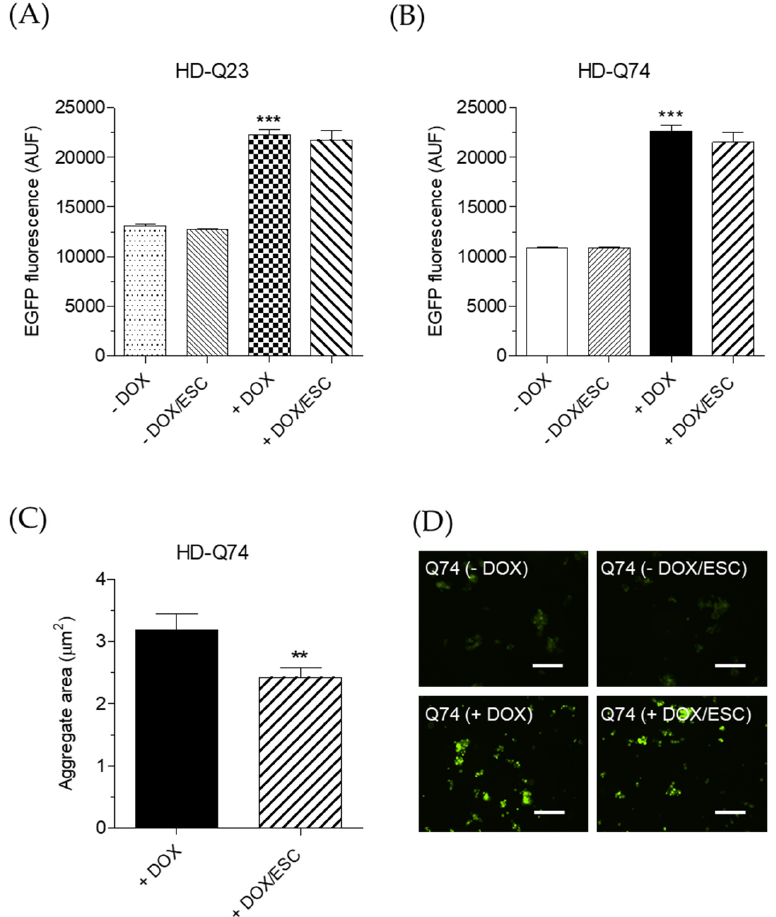
Figure 3. ESC inhibits mHTT aggregation in HD-Q74 cells. ( A , B ) HD-Q23 and HD-Q74 cells were incubated with DOX (1 µ g/mL) for 3 days and ESC (5 µ M) was added during the last 24 h of incubation with DOX. The fluorescence of both EGFP-tagged HTT23Q and HTT74Q aggregates was measured as described in the Materials and Methods. Data are expressed as AUF and reported as the mean ± SEM of at least three independent experiments (*** p < 0.001 vs. HD-Q23 ( − DOX) and *** p < 0.001 vs. HD-Q74 ( − DOX) at one-way ANOVA with Bonferroni post hoc test); ( C ) HD-Q74 cells were incubated with DOX (1 µg/mL) for 3 days and ESC (5 µM) was added during the last 24 h of incubation with DOX. The area of the fluorescent EGFP-tagged HTT74Q aggregates was measured using an inverted fluorescence microscope as described in the Materials and Methods. Data are expressed as area and reported as mean ± SEM of at least three independent experiments (** p < 0.01 vs. HD-Q74 (+DOX) at Student’s t -test); ( D ) Representative images of HTT74Q aggregates after treatment with ESC (scale bars: 100 µm).